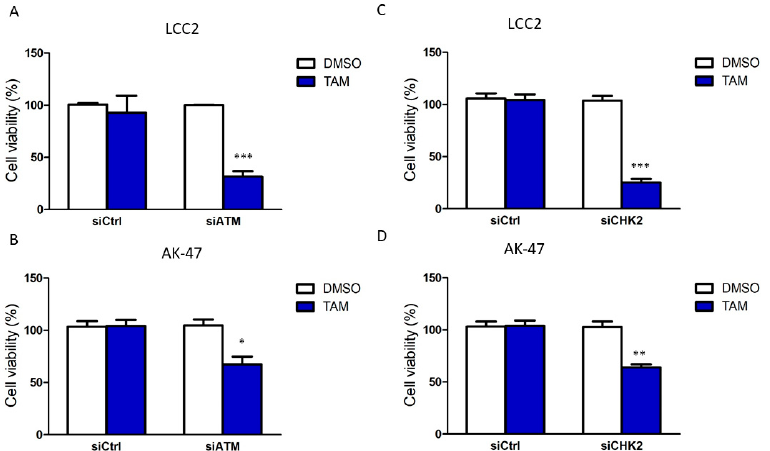
Figure 3. Knockdown of ATM and CHK2 could reduce TAM resistance. The effect of ATM knockdown on TAM response in ( A ) LCC2 and ( B ) AK-47. The effect of CHK2 knockdown on TAM response in ( C ) LCC2 and ( D ) AK-47. LCC2 and AK-47 are TAM-resistant cell lines. The cells were incubated with 20 nM of the siRNA and 4 µ M of TAM for 96 h. Cell viability was determined by MTT assay. Results are shown as mean ± SD from six independent experiments. Student’s t -test was employed to compare the statistical significance between DMSO and TAM groups: * p < 0.05, ** p < 0.01 and *** p <